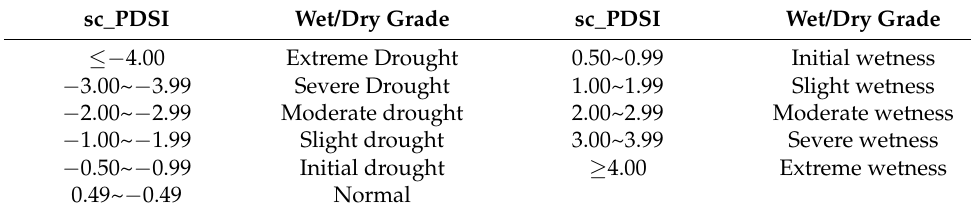
Table 1. sc_PDSI Dry and wet